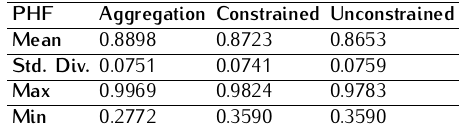
Table 1. Statistics of the PHFs by Calculation